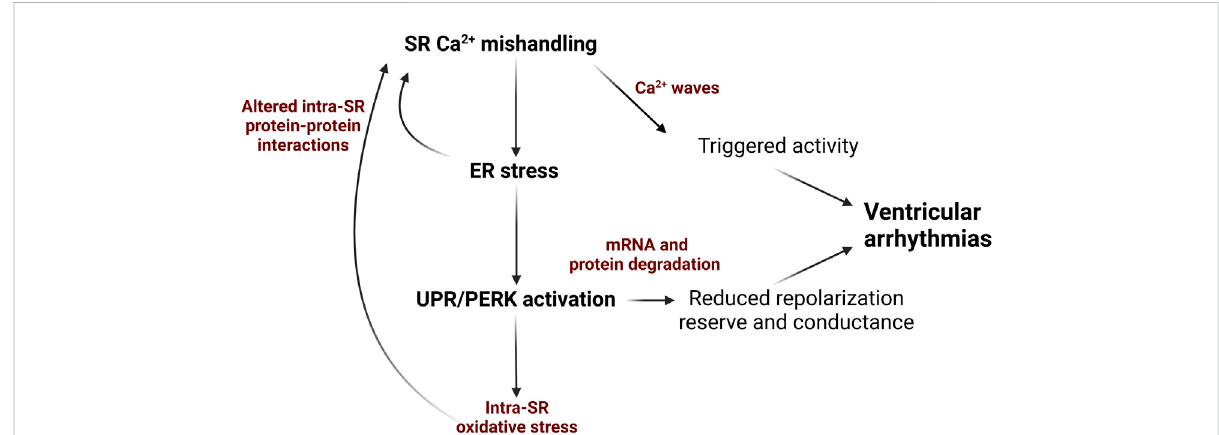
FIGURE 1 Schematic depicting how ER stress and the UPR can exacerbate SR Ca 2+ mishandling via in cardiovascular disease and contribute to Ca 2+ - dependent ventricular arrhythmogenesis. Diminished SR Ca 2+ content due to decreased SERCA2a activity and/or increased RyR2 activity evokes ER stress and UPR that promotes ROS production mRNA and protein degradation and impair protein-protein interactions in Ca 2+ -handling complexes. This results in decreased repolarization reserve and slowing conduction due to reduction in K + and Na + ion channels in the plasmalemma. Additionally, further enhancement of RyR2 activity and reduction in SERCA2a activity promotes generation of pro-arrhythmic spontaneous SR Ca 2+ waves. Image created with